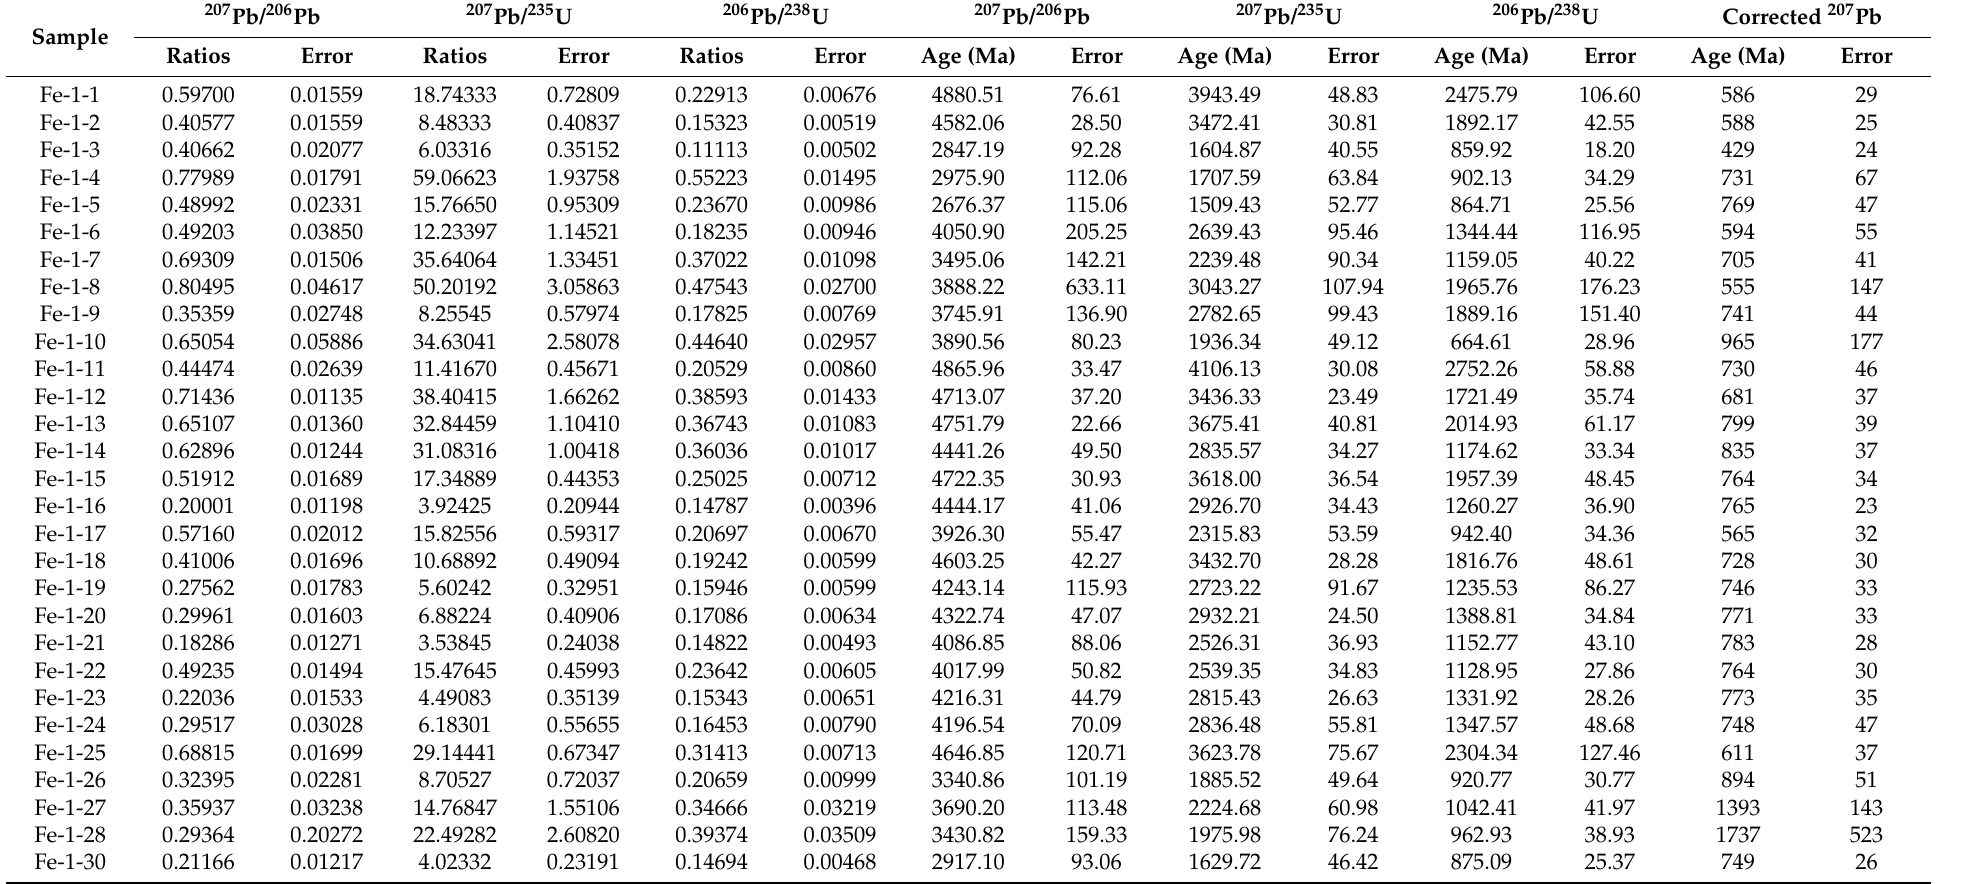
Table 2. Monazite U–Pb isotopic data of the sample Fe-1 from the Bayan Obo